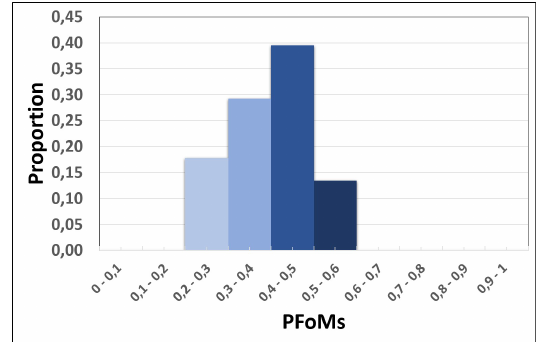
Figure 2. Histogram of proportions of PFoMs obtained with the Adaptive Canny Method for Small objects, from 1 to 6 pixels, both